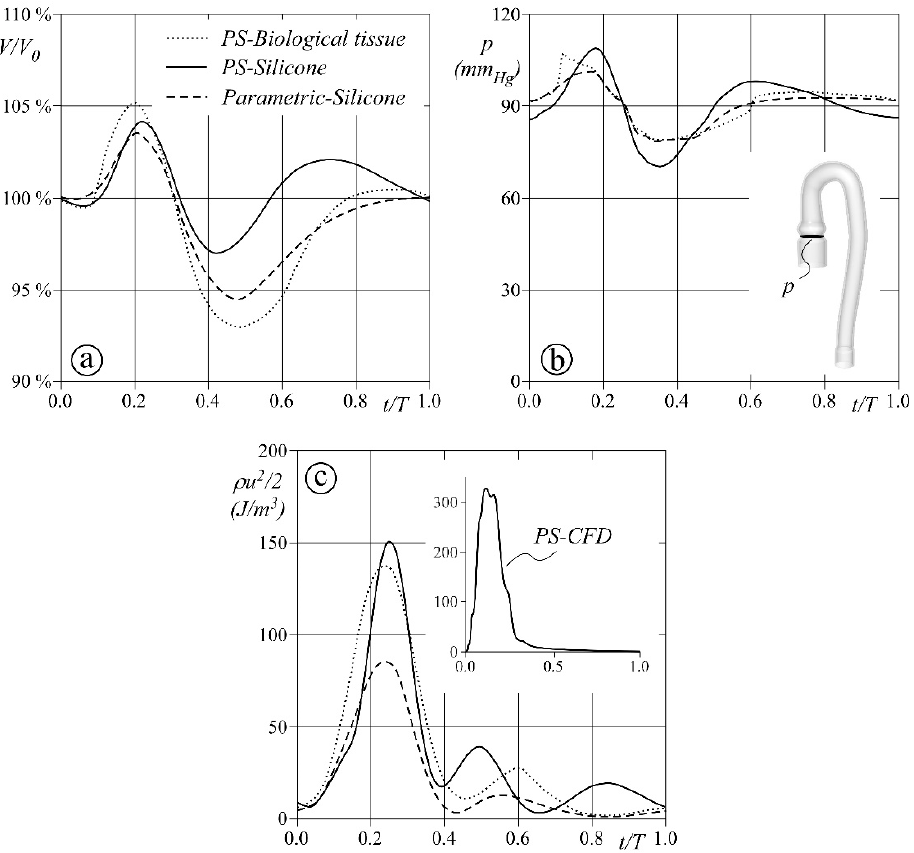
Figure 10. Global performance of the three aortas during the cardiac cycle. ( a ) Total volume variation; ( b ) mean pressure at the aortic valve inlet; and ( c ) mean flow kinetic energy.